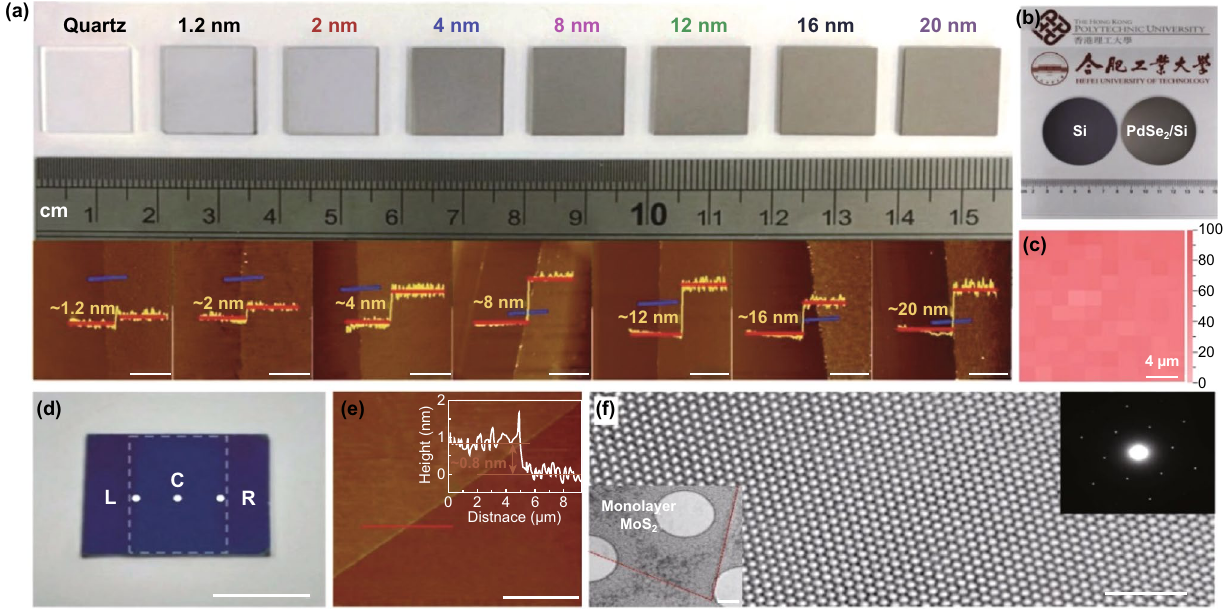
Fig. 2 Large-area CVD synthesised TMDCs. a Optical images of CVD synthesised PdSe 2 (top) and corresponding AFM height profiles (bot- tom) showing the obtained tuned thicknesses. b Optical image of a 2D PdSe 2 wafer-sized synthesised product with a plain Si substrate. c Raman intensity mapping of a 20 × 20 µm 2 area indicating good film uniformity. Adapted with permission from Ref. [28]. Copyright 2019, Wiley. d Optical image of a CVD grown MoS 2 grown from oxide precursor from an engineered configuration. e AFM image and the inset thickness profile corresponds to a MoS 2 monolayer. f High-resolution transmission electron microscope (HRTEM) image from left inset showing highly quality crystal. The right inset shows the selected area diffraction pattern. Adapted with permission from Ref. [25]. Copyright 2017, Wiley. Scale bars are 2 µm ( a bottom), 1 cm ( d ), 10 µm ( e ), 2 nm ( f